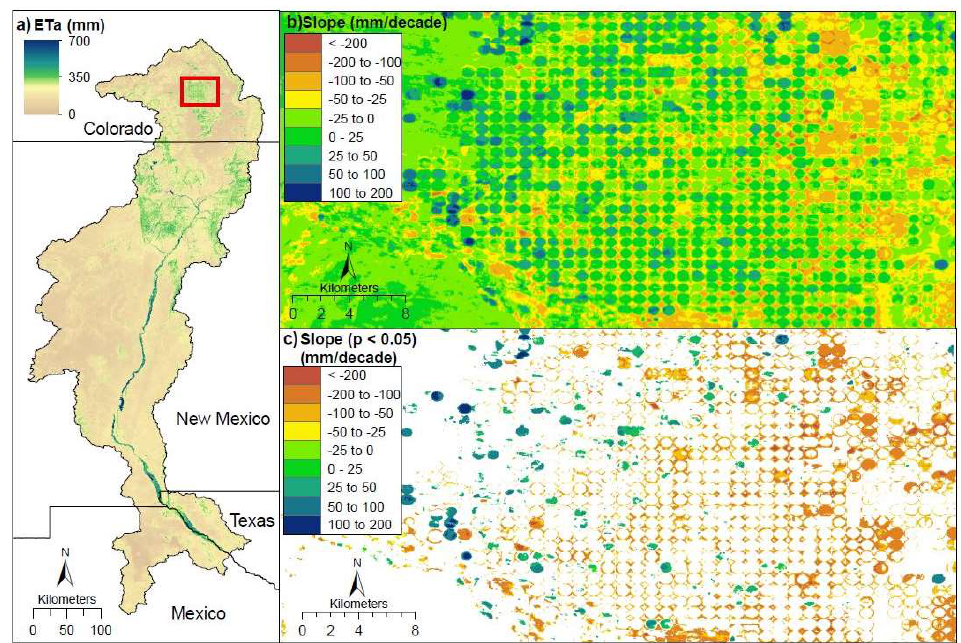
Figure 10. Pixel-based rate of change in seasonal crop water use ( ETa ) for center pivots in the Colorado part of the URGB. ( a ) Landsat based summer median (1986–2015) ETa , ( b ) rate of change (mm / decade) in seasonal (June–August) crop water use ( ETa ), and ( c ) rate of change (mm / decade) of ET for only statistically significant pixels using pixel-based MK analysis at p < 0.05.